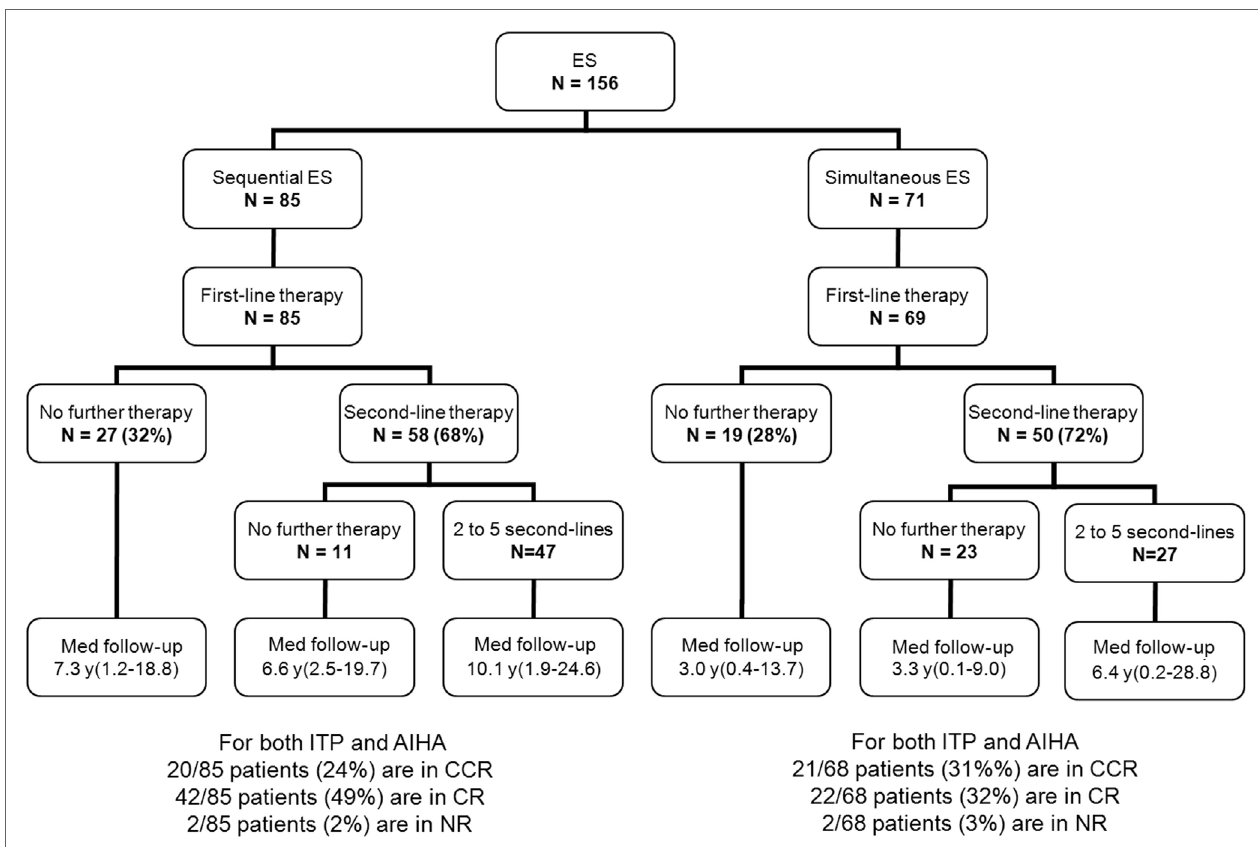
FigUre 2 | Management and outcome of 156 children with es